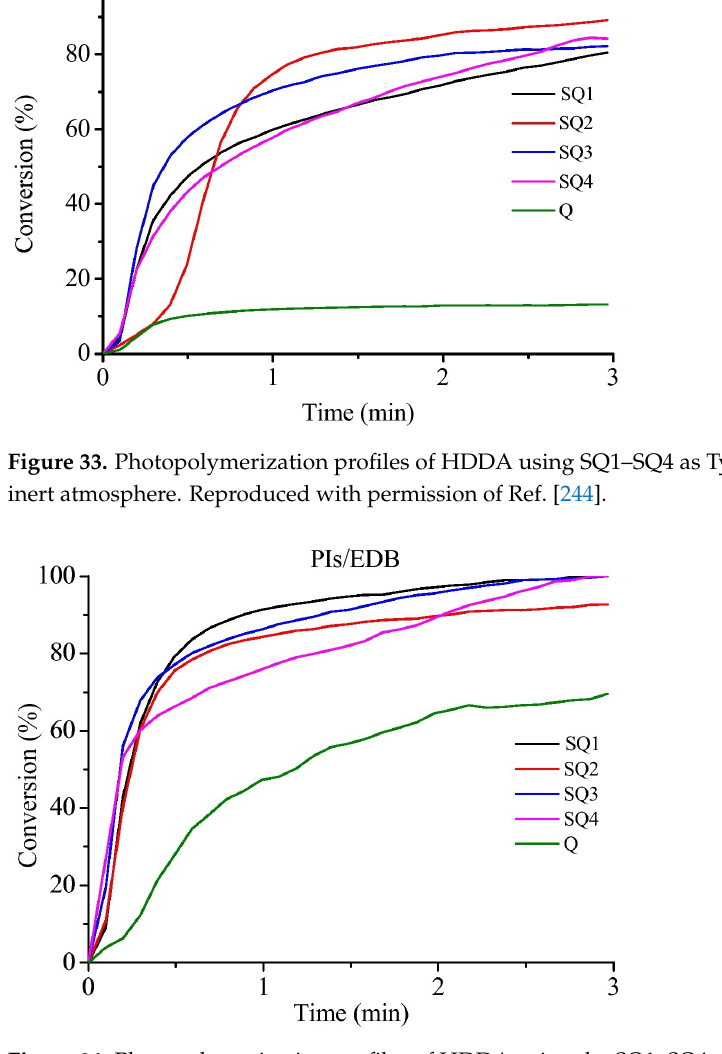
Figure 34. Photopolymerization profiles of HDDA using the SQ1–SQ4 as Type II photoinitiators in combination with EDB under inert atmosphere. Reproduced with permission of Ref. [244] .